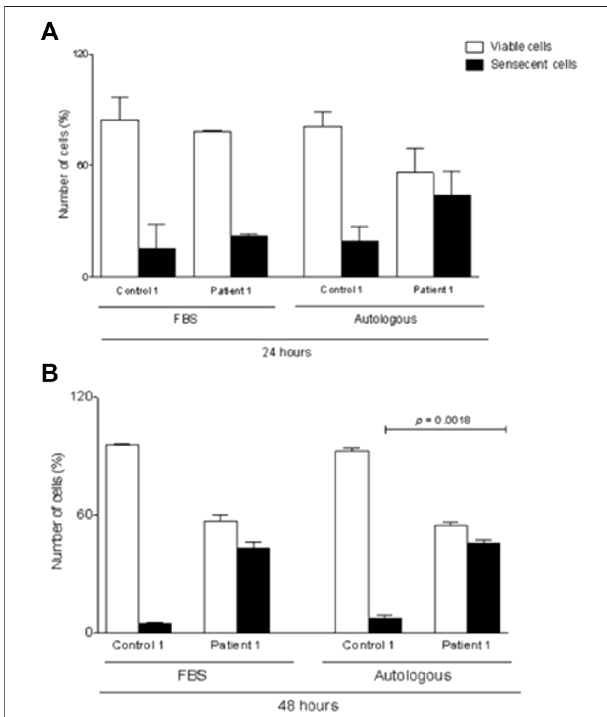
FIGURE 3 | β -galactosidase staining of BM – MSCs from healthy control and patient maintained in culture for 24 and 48 h. (A) Staining of senescent cellsfromhMSCculturesupplementedwith10%FBSand/or10%autologous serum. (B) Quanti fi cation of senescent cells from hMSC culture supplemented with 10% FBS and/or 10% autologous serum. Data are mean ± SD. Statistical signi fi cance is shown using Student ’ s t -test analysis ( n = 3); * p =